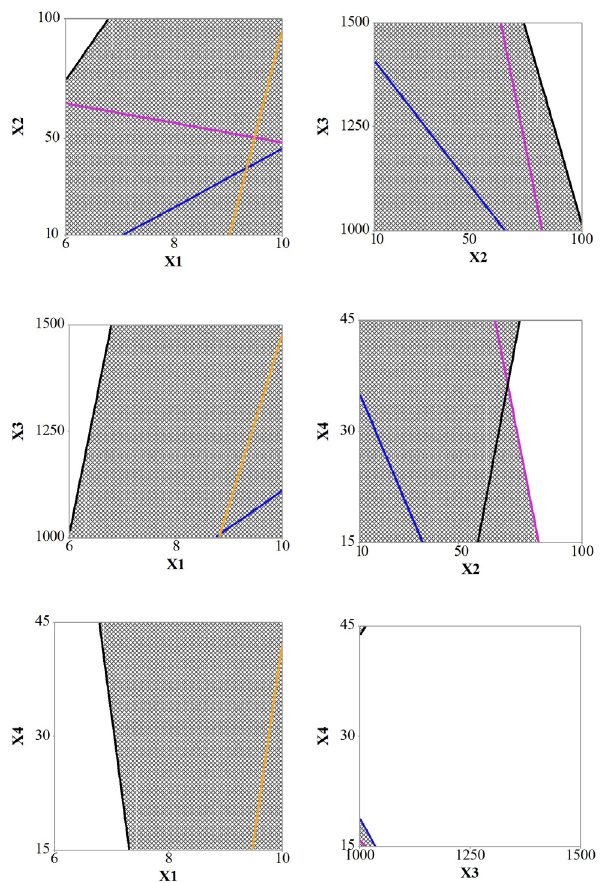
FIGURE 3 - Design space contour plot of PGZ (Y1 ≥ 20%), Keto-P (Y2 ≥ 20%), OH-P (Y3 ≥ 20%), and RSG (Y4 ≥ 20%) as function of pH (X1, 6 to 10), HCl concentration (X2, 10 to 100 mmol/L), agitation speed (X3, 1000 to 1500 rpm), and extraction time (X4, 15 to 45 min).